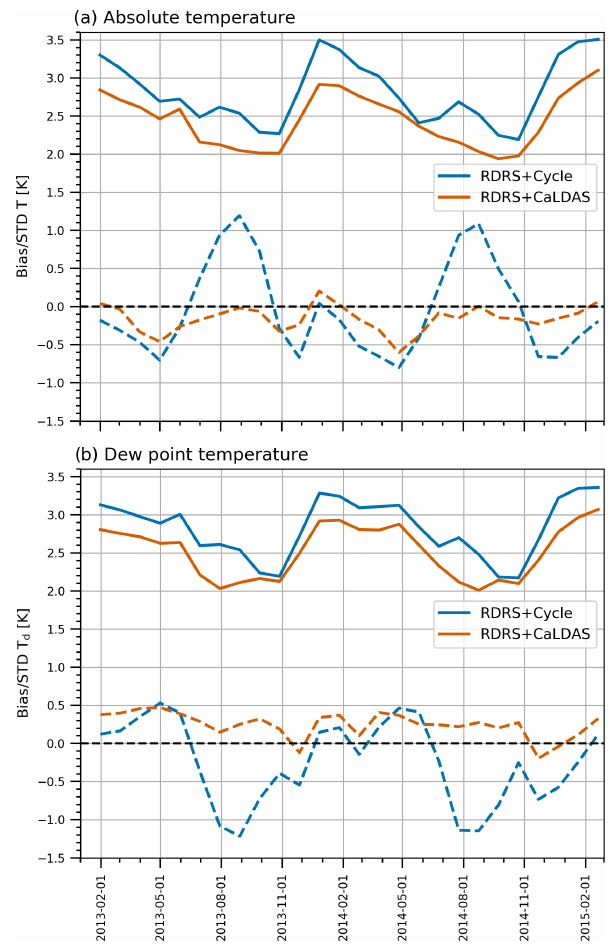
Figure 5. Comparison of reforecast surface results from RDRS + Cycle (blue) and RDRS + CaLDAS (orange) against SYNOP observations in terms of STDE (top curves, solid lines) and bias (bottom curves, dashed lines) computed based on monthly intervals for the whole North America and the 2013–2014 years: (a) absolute temperature; (b) dew point temperature. Results based on a combination of 6 to 17h lead time from integrations starting at 00:00 and 12:00UTC.